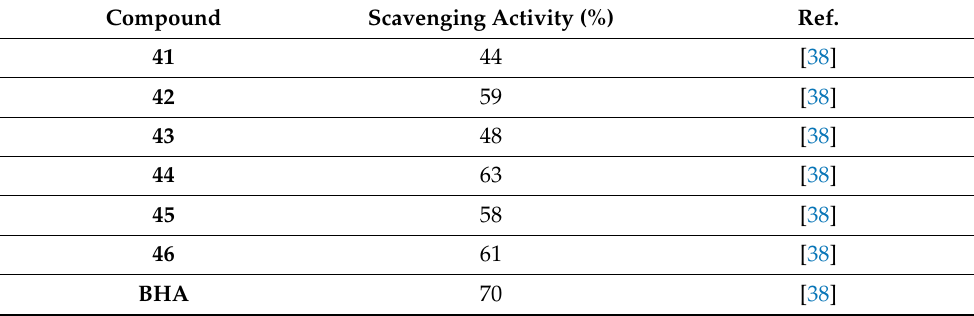
Table 3. Antioxidant activity of selected coumarin-derived imine–metal complexes.